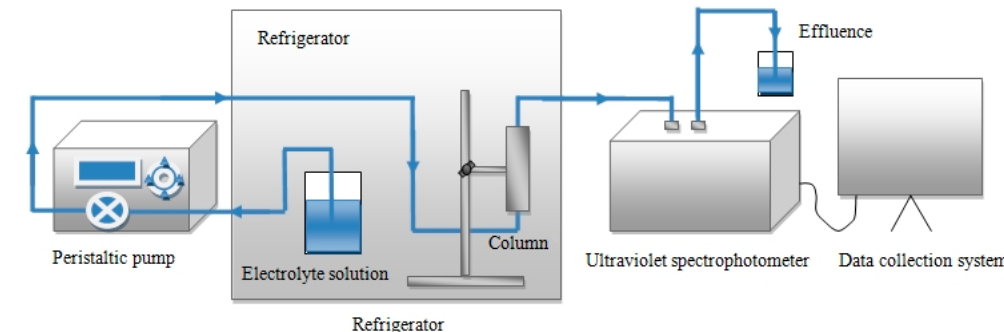
Figure 2. Schematic diagram of the experimental setup.